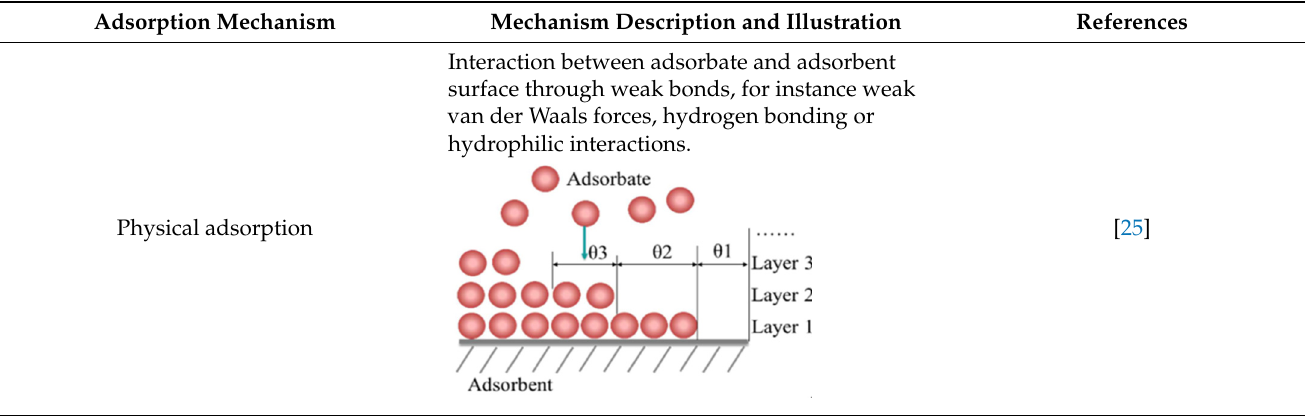
Table 5. Several common adsorption mechanisms of adsorbent toward adsorbate. Adopted from reference [25] (copyright reserved Elsevier, 2020).